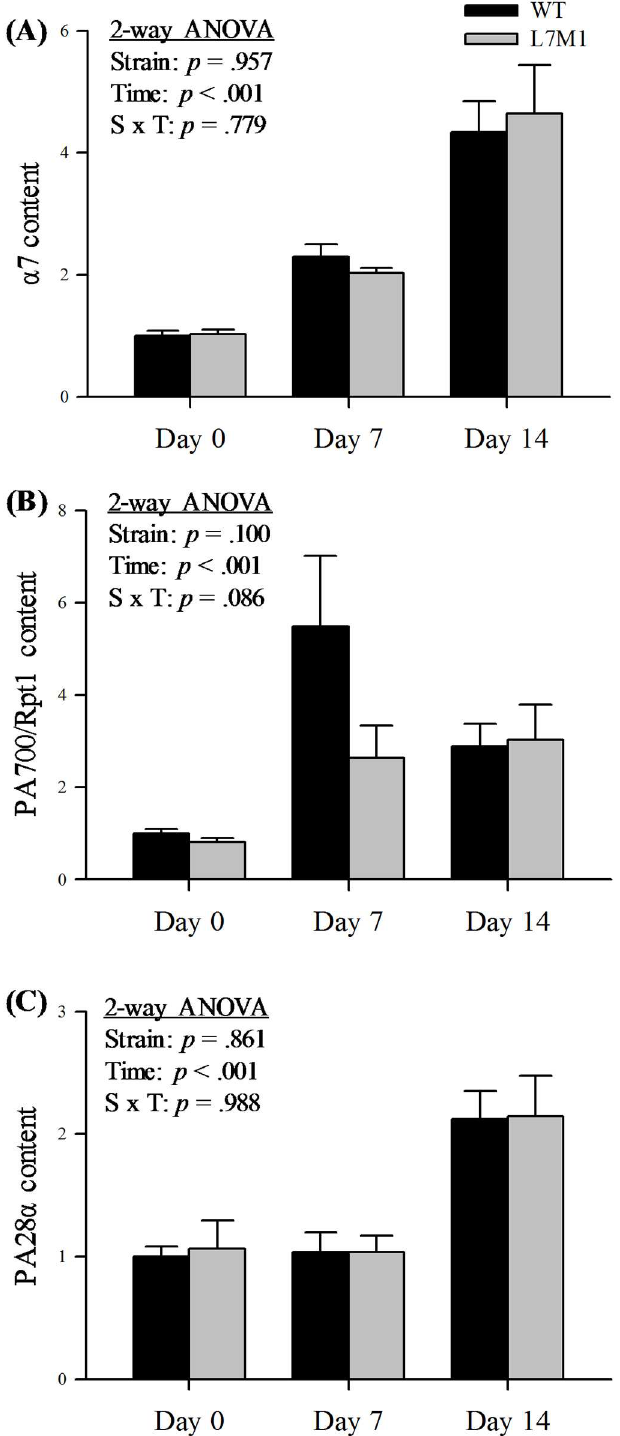
Fig 3. Protein content of α 7 and proteasome activators in WT and L7M1 mice with denervation. (A-C) Results of densitometry are presented as the fold changecomparedto WT 0 Day for each respectiveprotein. Each panel containsresults of two-way ANOVA that were used to detect the effect of strain (WT vs. L7M1) and time (Day 0, 7, and 14) for (A) α 7, (B) PA700/ Rpt1, and (C) PA28 α (# indicatessignificanteffect of strain/ time/S x T interactions, p < .05). Statistical comparisonshoweda significantdenervation (time) effect in all the